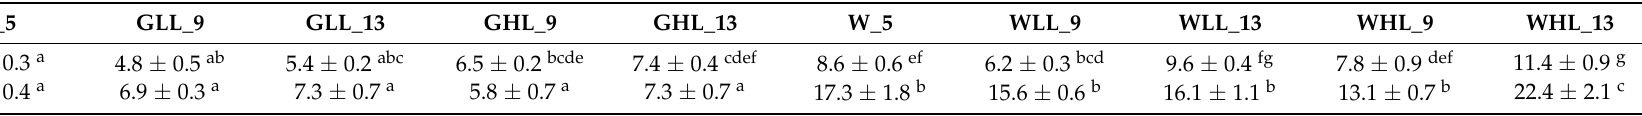
Table 1. Total free amino acid (AA) content in GL and WL of P. zonale plants at the beginning (5 d) and after four (9 d) and eight days (13 d) of high light exposure